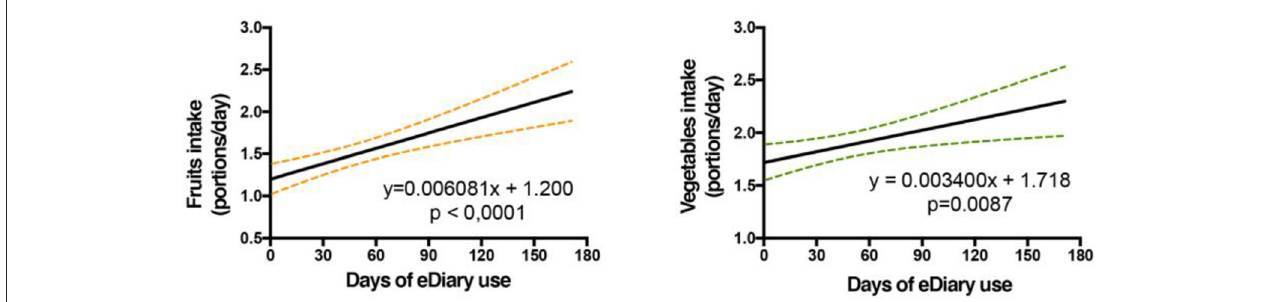
FIGURE 8 | Increase in fruit and vegetable intake during the use of the e-Diary app for the users who used the app at least one time ( N = 297): a linear regression analysis was performed between the number of servings taken per day and the days of use of the e-Diary app. Only the days that had an e-dairy record were included. P -values indicate the significance of the Pearson correlation between dietary behaviors and the days of e-Diary app use. The average of days of use of the eDiary is 21.7 (SD = 22.6) for the 297 participants who used the eDiary at least once. TABLE 7 | Logistic regression model between the engagement with the e-Diary app and the DTBs. Crude OR Adjusted OR Engaged in the e-Diary for Engaged in the e-Diary for < 2 weeks ≥ 2 weeks < 2 weeks ≥ 2